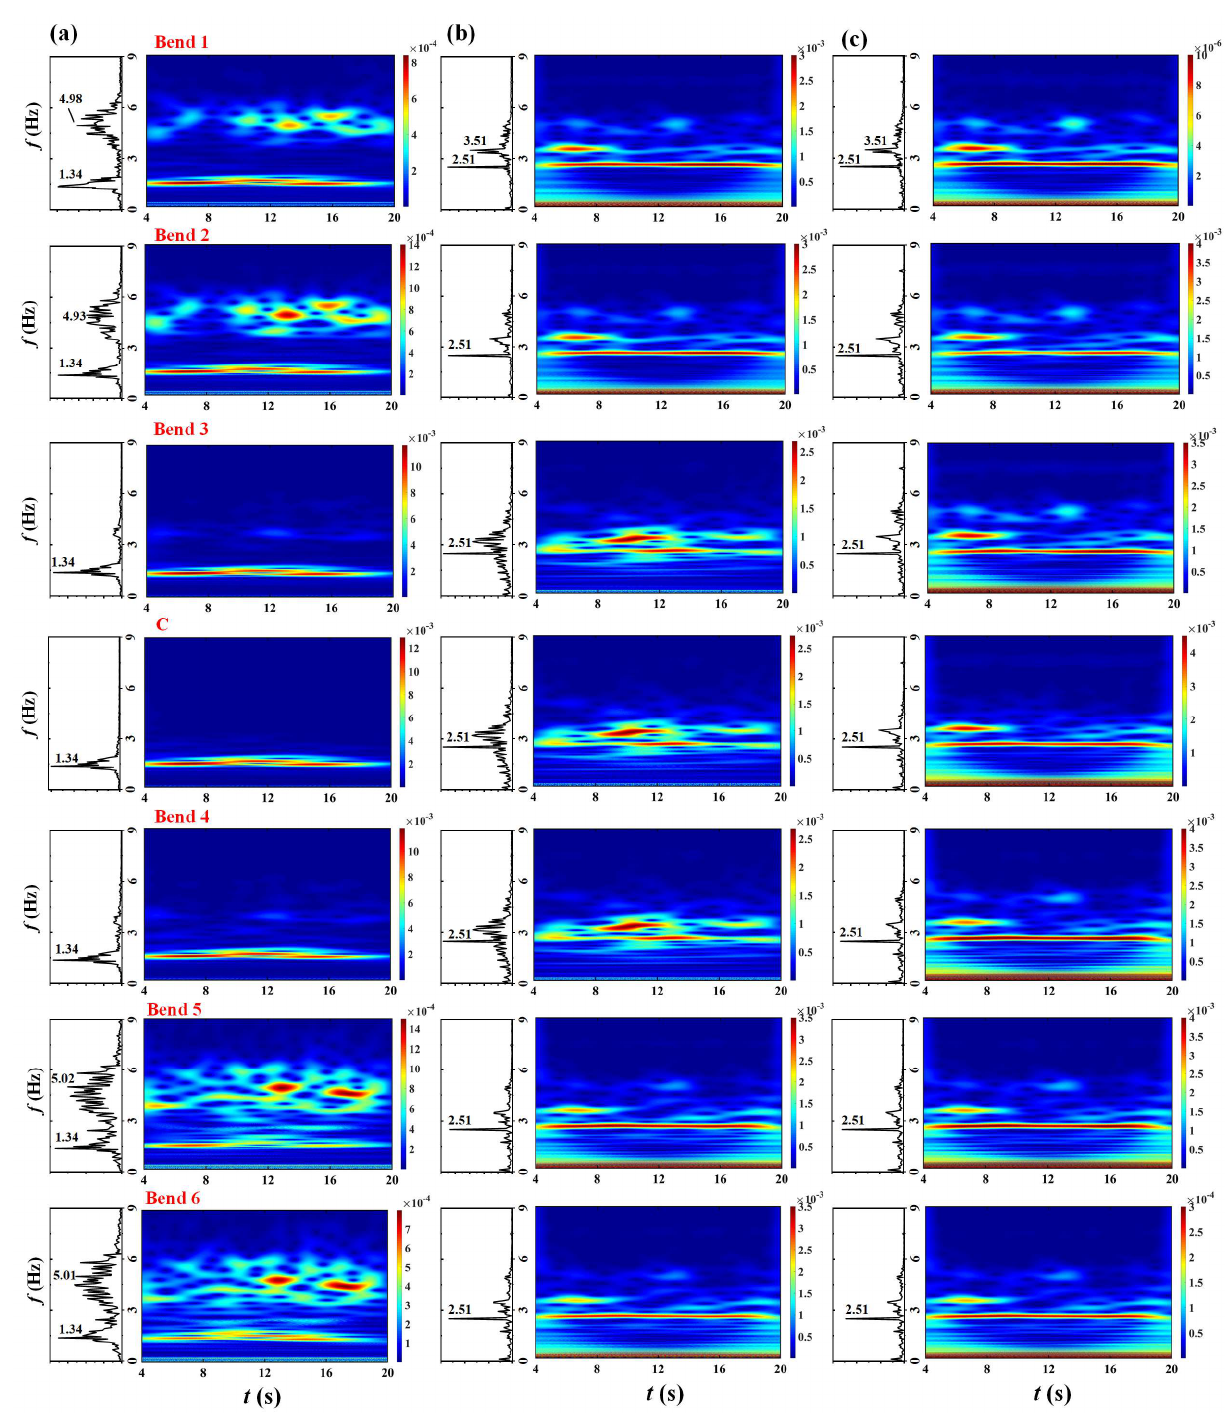
Figure 10. The vibration frequencies of monitored bends and probe in case 1, where f is the fluctuation frequency and t is the flow time: ( a ) variation of frequency in X direction; ( b ) variation of frequency in Y direction; ( c ) variation of frequency in Z direction.